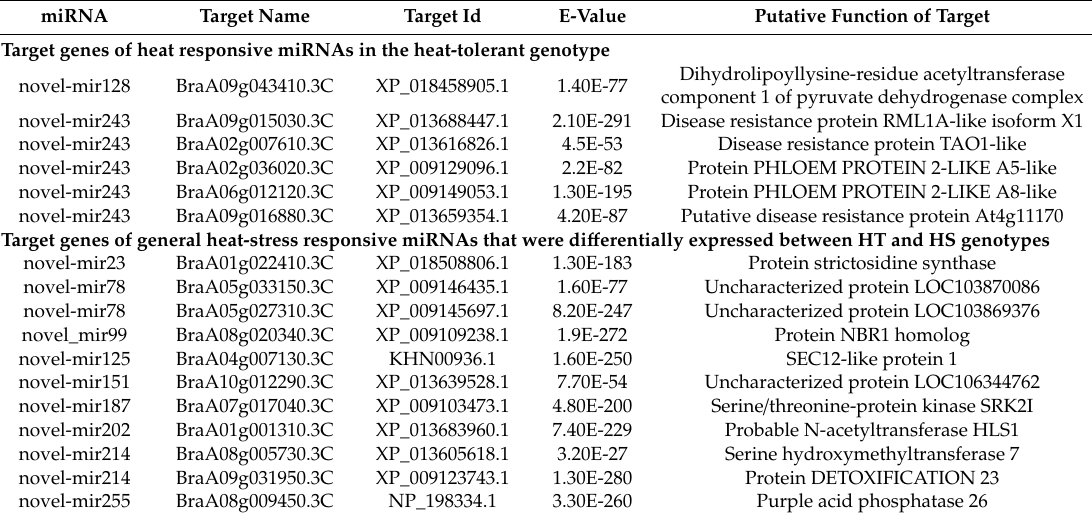
Table 4. Potential targets of di ff erentially expressed novel miRNAs in flowering Chinese cabbage genotypes under heat